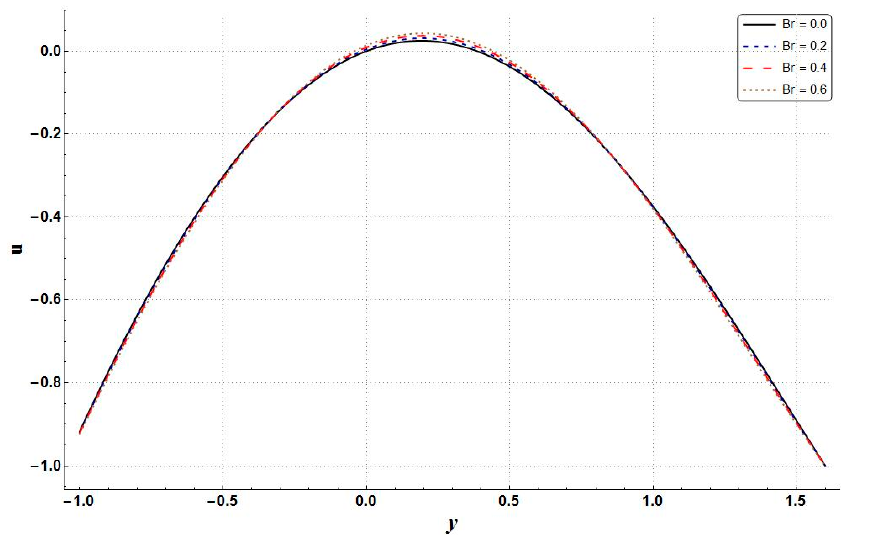
Figure 14. Influence on u through changing values of Br , where γ = π φ = 0.05, k = 2, a = 0.6, M = 1, d = 0.7, m = 1, b = 0.5, ∈ = 2, η = 0.8.